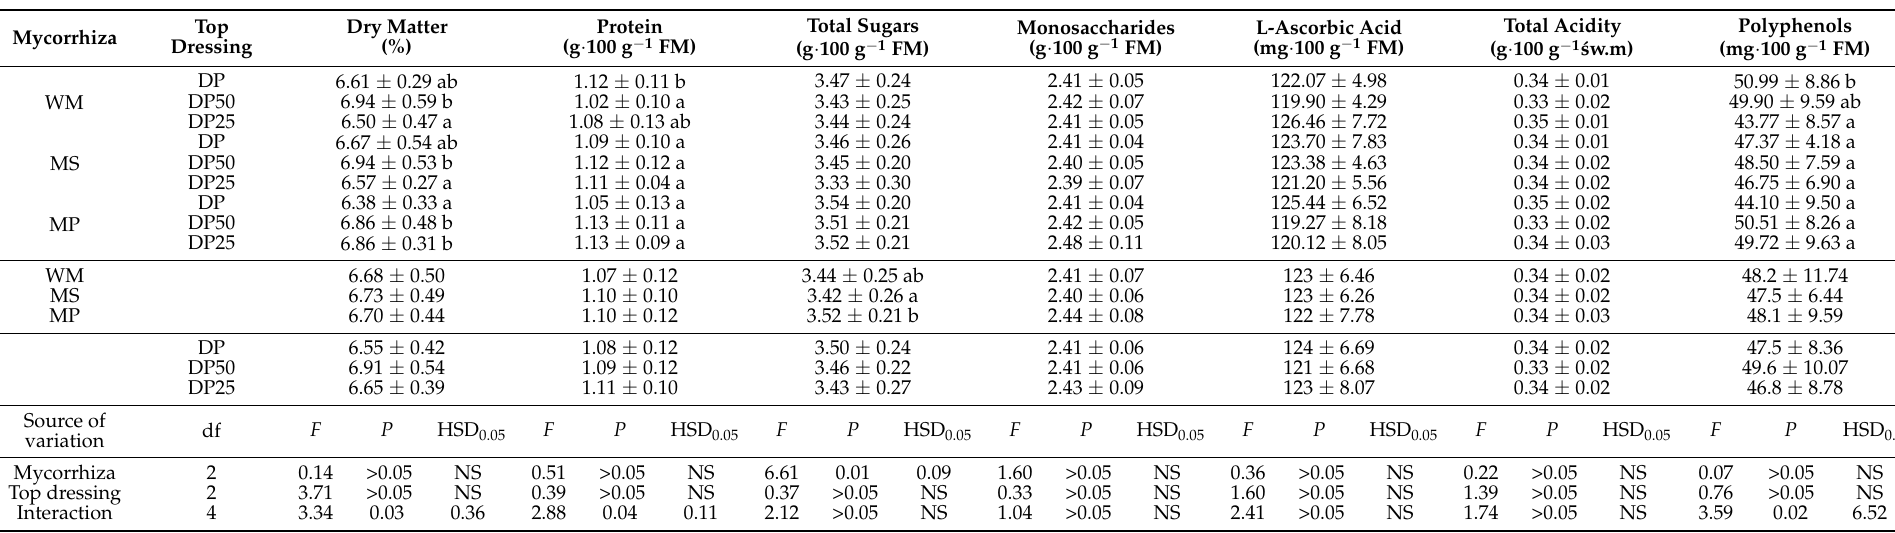
Table 8. Content of selected elements of nutritional value in sweet pepper fruits; on average across three years